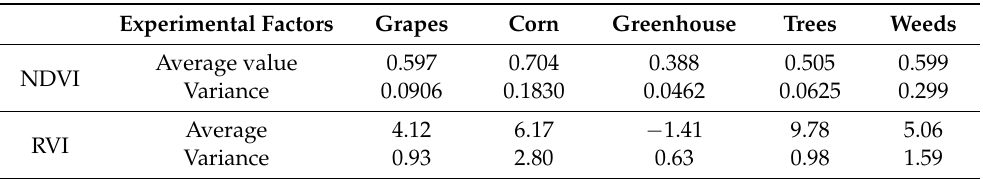
Table 5. NDVI and RVI values of different